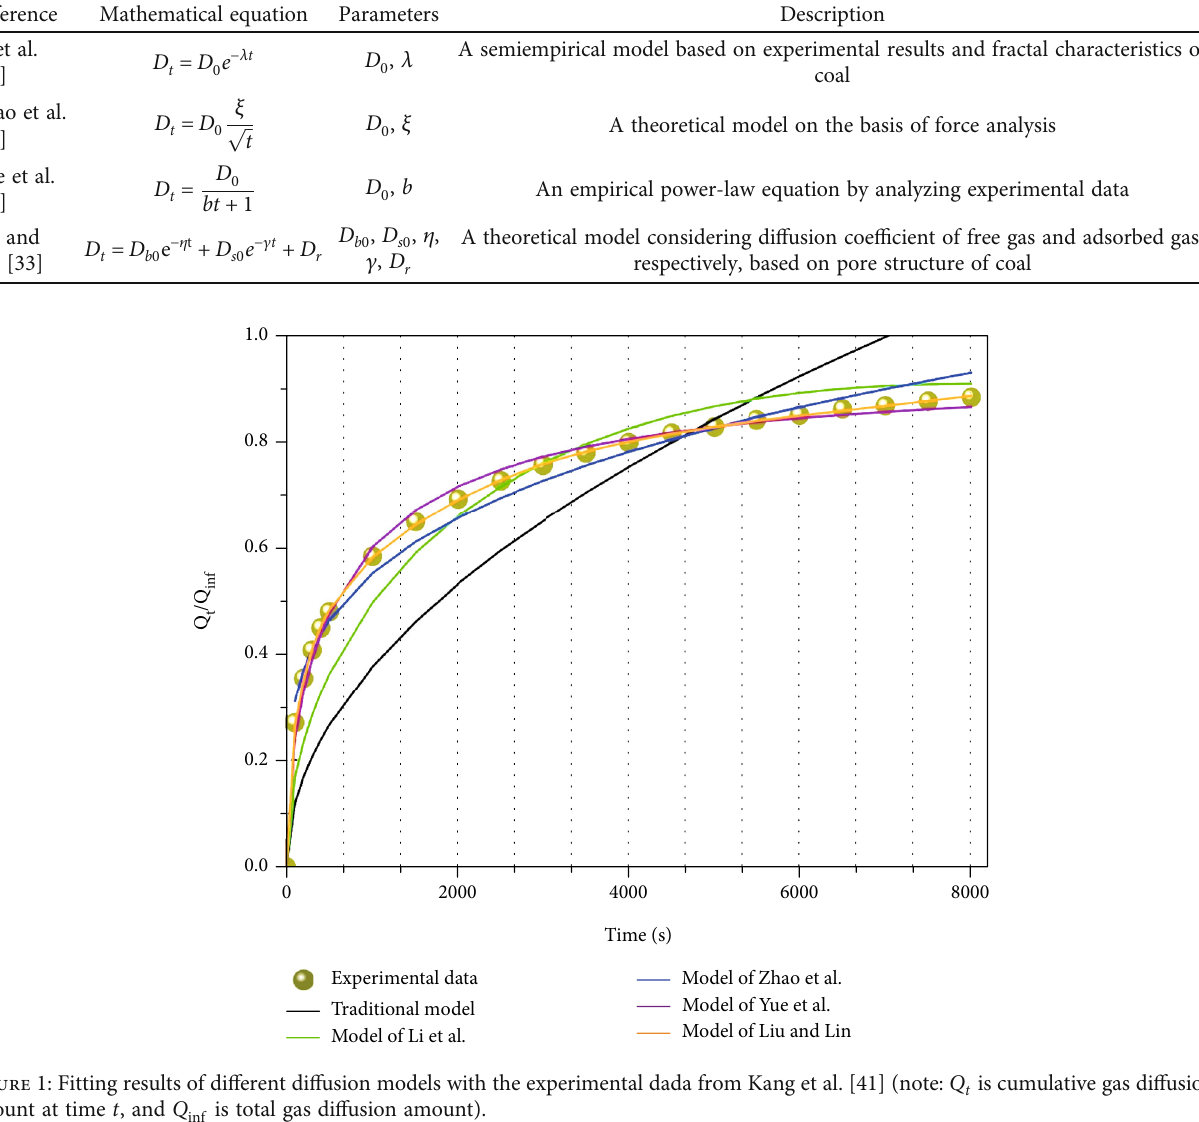
Table 1: Dynamic di ff usion models from di ff erent studies.